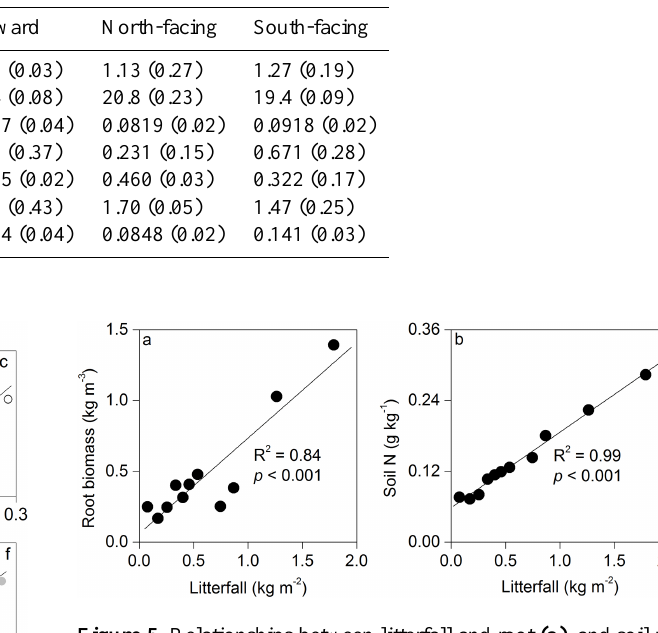
Figure 5. Relationships between litterfall and root (a) , and soil ni- trogen content (soil N) (b) over the measurement